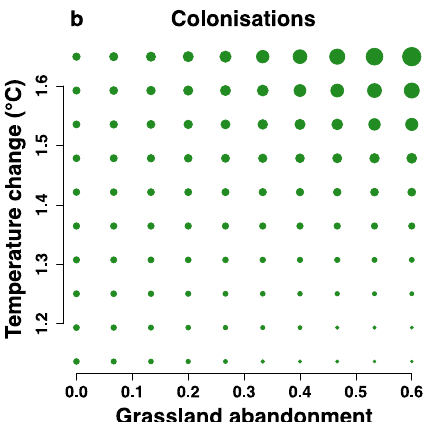
values of each predictor variable. In a , grassland retention was related to fewer extirpations, but this effect was reduced in warmer climates (model R 2 -marginal = 0.12, R 2 -conditional = 0.49). In b , high levels of grassland abandonment and tem- peratureincreaseswereassociatedwiththemostcolonisations(modelR 2 -marginal= 0.04, R 2 -conditional = 0.16). See Supplementary Data 6 for full model